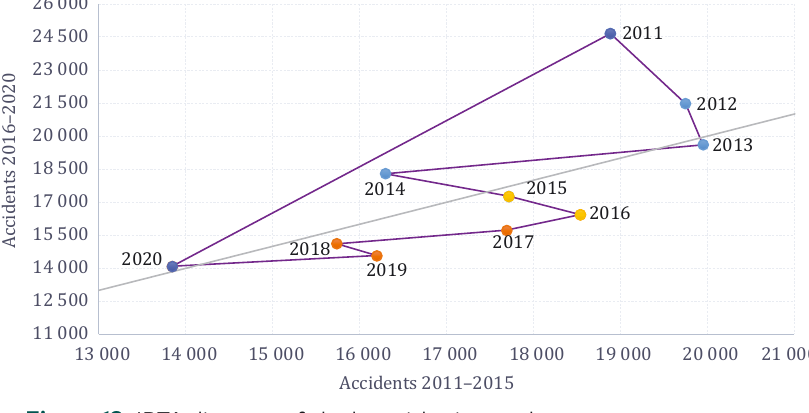
Figure 13. IPTA diagram of the logarithmic trend